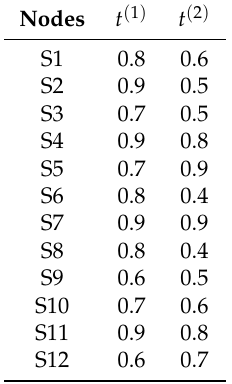
Table 3. The updates status of nodes in the